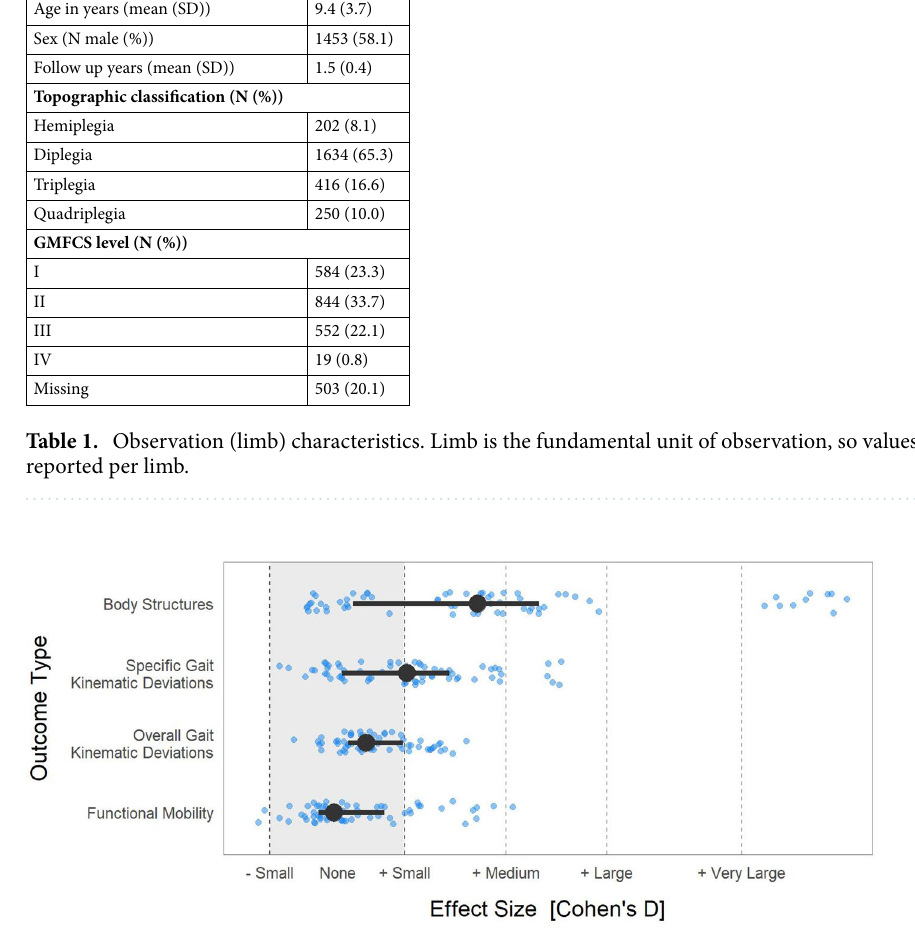
Figure 1. Median and interquartile range of short-term ATT across all treatments, models, and outcomes (large circles and horizontal lines) and individual model estimates across 5 models per outcome (small circles). We use conventional values for effect size thresholds (small ≥ 0.2, medium ≥ 0.5, large ≥ 0.8, very large ≥ 1.2). The very large effects are from Selective Dorsal Rhizotomy (mean spasticity) and Femoral Derotation Osteotomy (femoral